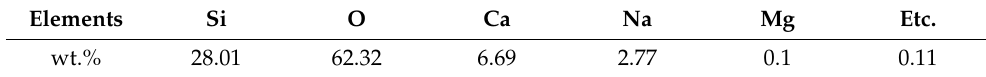
Table 4. EDS results for raw GHS.